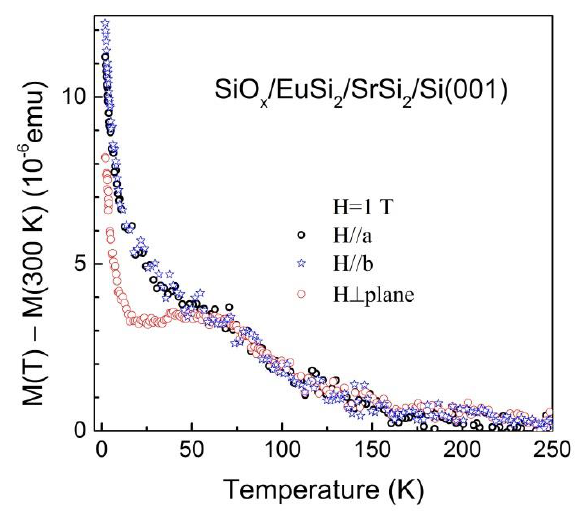
Fig. 5. Temperature dependence of magnetic moment of the SiO x /EuSi 2 /SrSi 2 /Si(001) film for different directions of the external field (1 T) with respect to the substrate: (001)